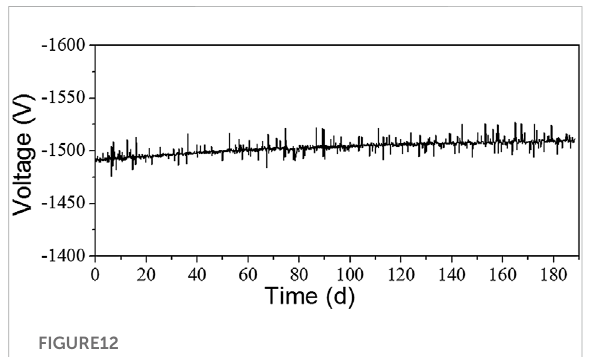
FIGURE12 The curve of the operating voltage of the electron multiplier with time after it enters the stable working